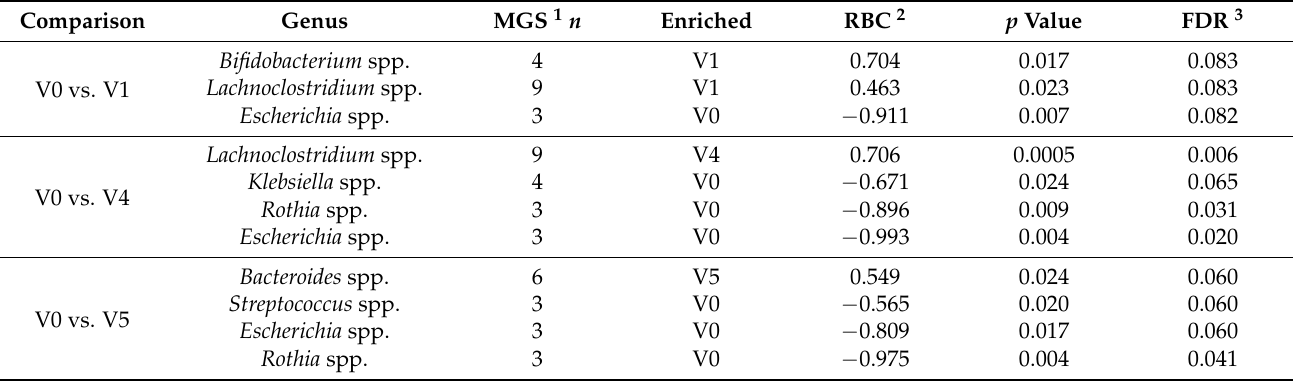
Table 3. Summary of significant findings from the taxon set enrichment analysis (at genus level) performed on the associations of the relative abundances of metagenomic species (MGS) with visits.